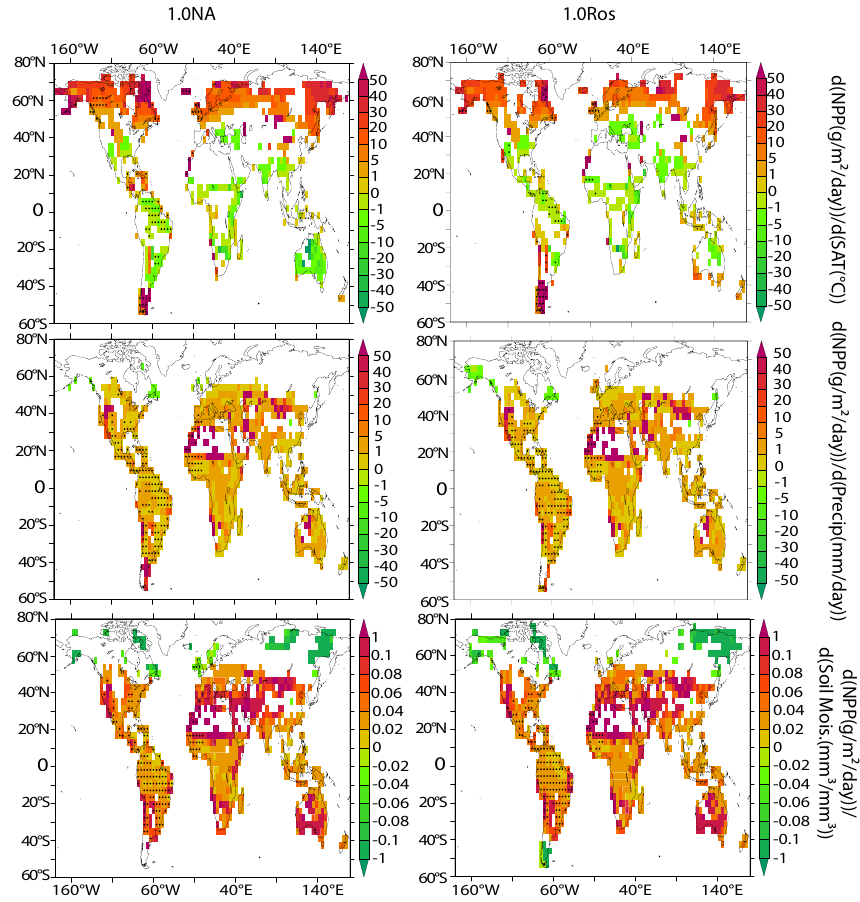
Fig. 7. Results of a linear regression analysis between NPP (gm − 2 day − 1 ) and the climatic variables of SAT ( ◦ C, top), precipitation (mmday − 1 , middle), and soil moisture (mm 3 mm − 3 , bottom). Colour shading represents the sensitivity of NPP to the changes of these variables (slope of the linear regression). Only the grid cells with a value of the square of the correlation coefficient greater than 0.1 ( R 2 > 0.1) are coloured and the cells with R 2 > 0.5 are both coloured and stippled. The 1.0NA experiment is given on the left column and 1.0Ros on the